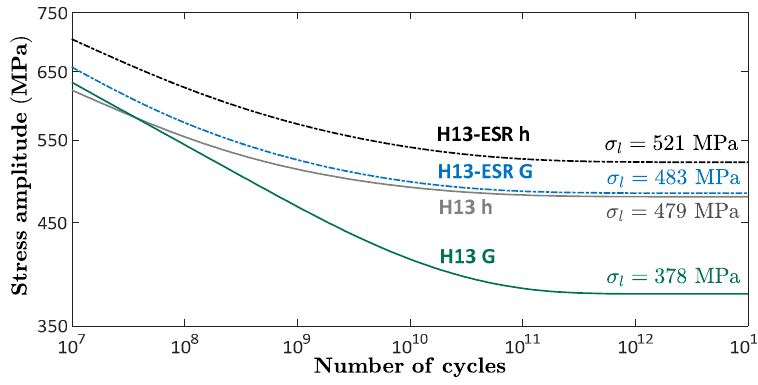
Figure 8. The 0.01th P–S–N curves for the tested H13 steels.